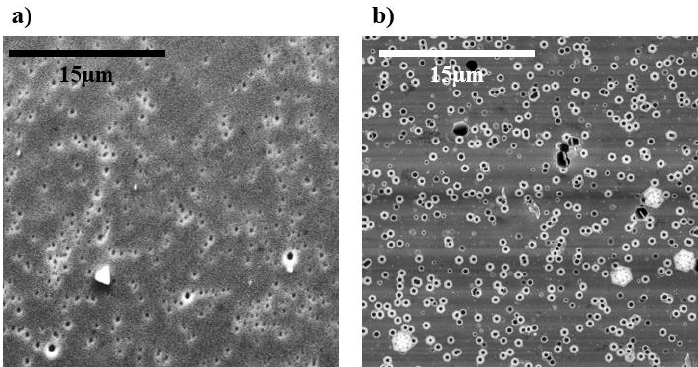
Figure 10. SEM images of the etched surfaces of the overgrown GaN crystal on in-situ etched seed ( a ) and untreated seed ( b ) after defect selective etching (DSE) experiments.